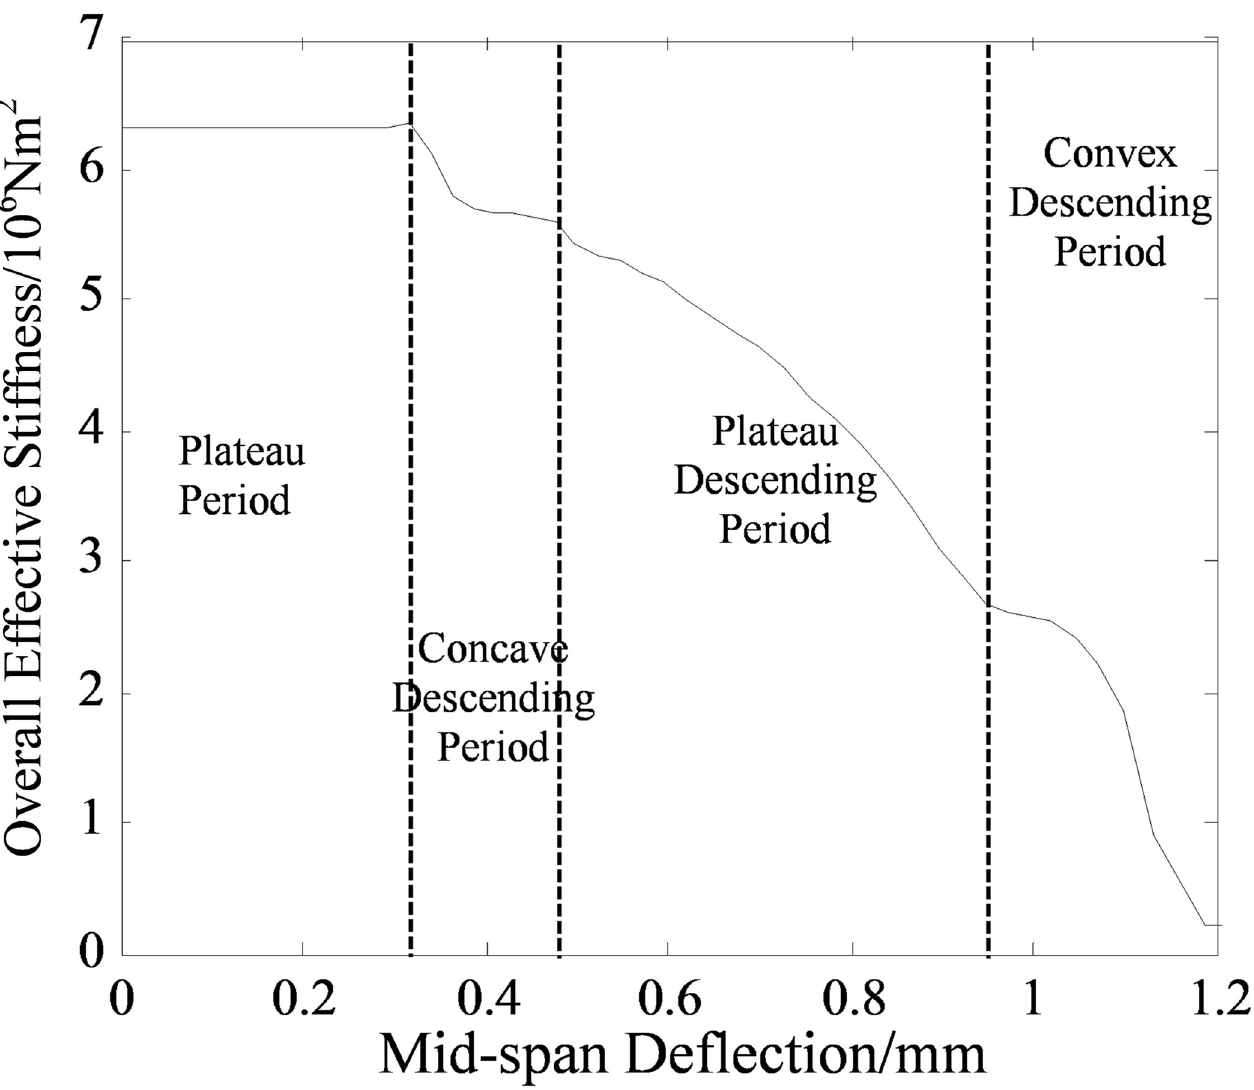
Fig 17. The relationship between the overall effective stiffness and mid-span deflection. The overall effective stiffness ~ B ~ is defined as the product of the bending moment M of the portion subjected to pure bending and the mean curvature φ of the beam axis. The curve of overall effective stiffness can be divided into four stages, including steady increasing period, concave descending period, steady descending period and convex descending